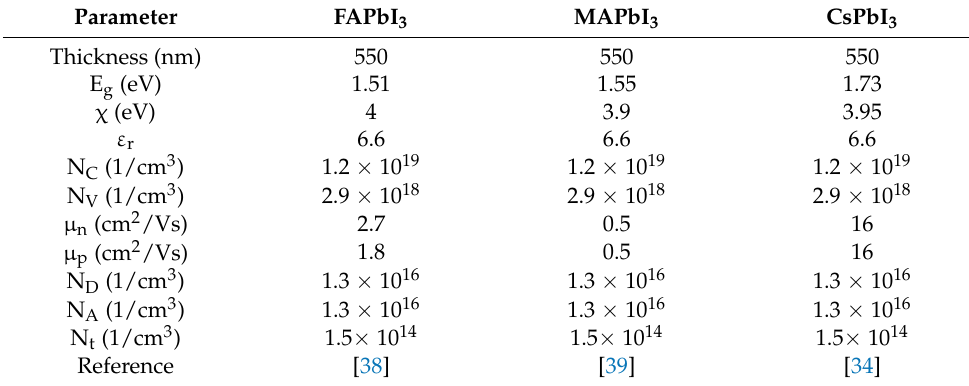
Figure 1. Configuration of perovskite solar cells used for simulations. Table 1. Cell parameters used for simulations.